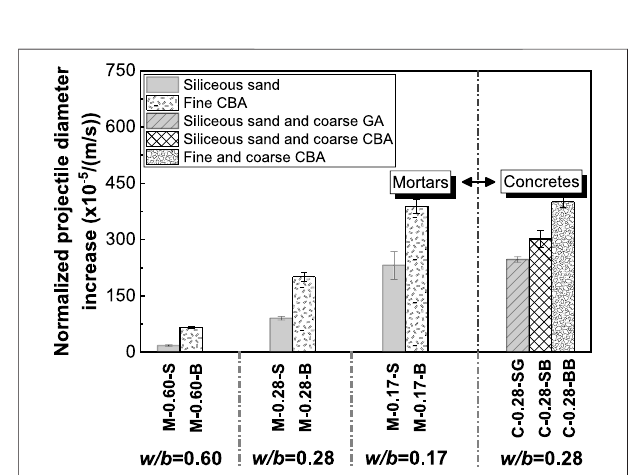
FIGURE 10 | Effect of CBA on the normalized diameter increase of deformable copper